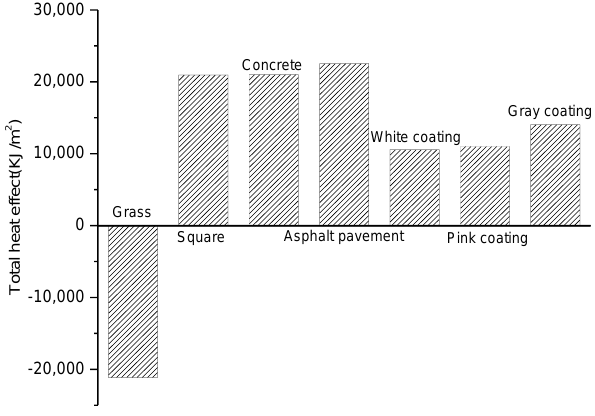
Figure 13. Thermal effect of different underlying surface.